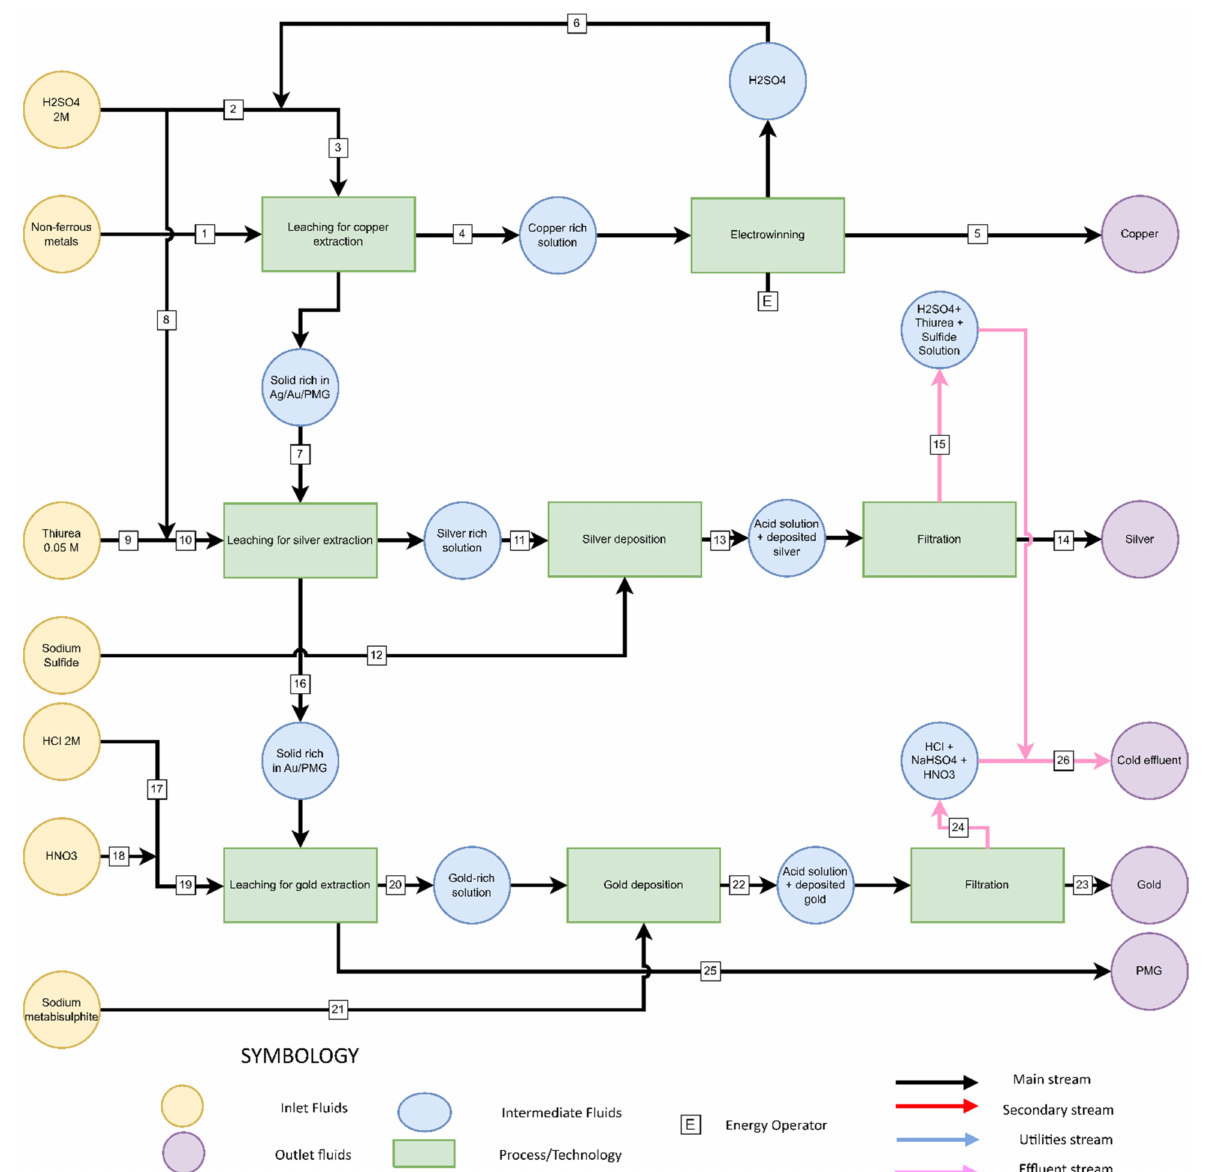
Figure 2. Block diagram of the second part of the proposed process